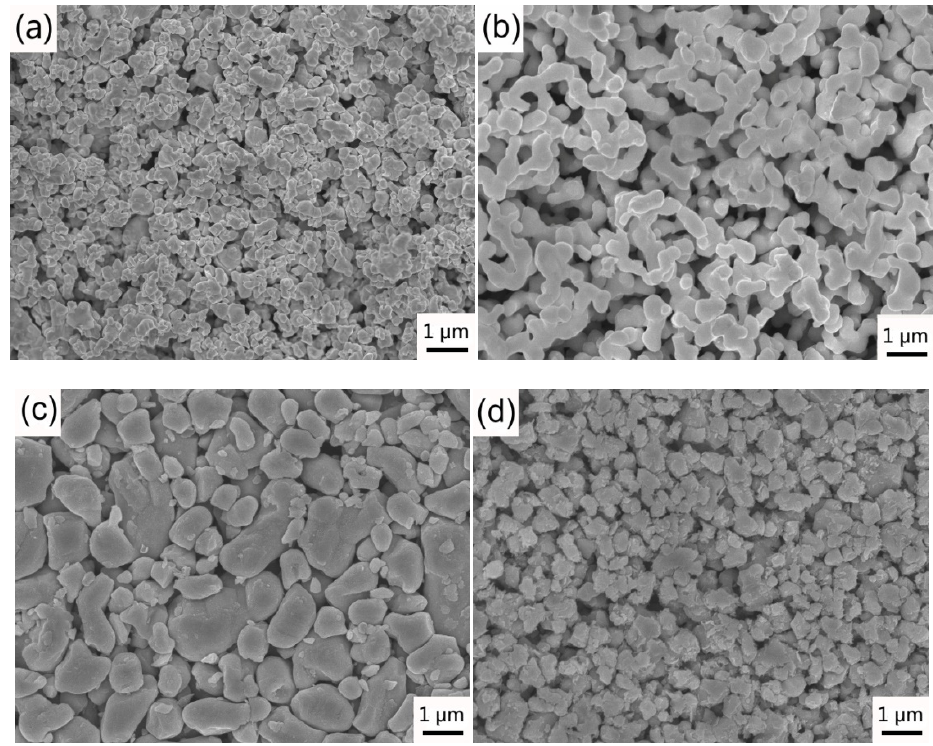
Figure 1. SEM images of ( a ) WC; ( b ) Co; ( c ) Cr 3 C 2 and ( d ) VC raw powders. Table 1. Composition ratios and number of the WC–6Co–(Cr 2 C 3 /VC) cemented carbides (wt. %).